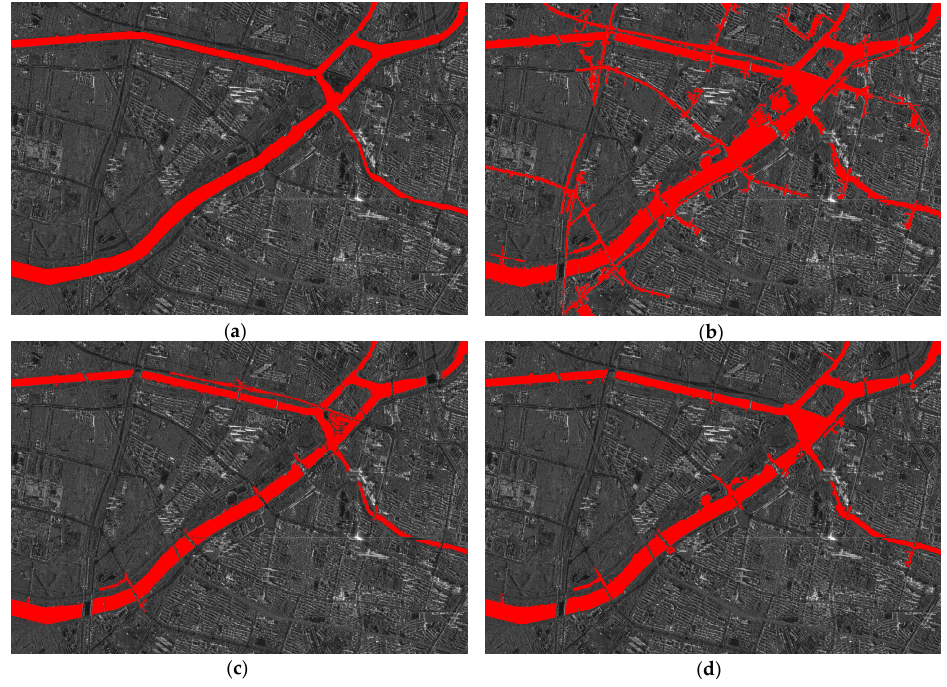
Figure 8. Comparison of riverway extraction results. Panels ( a – d ) are the extraction results of the proposed method, 1-D Otsu method in [12], 2-D Otsu method in [13], and FCM method in [16].